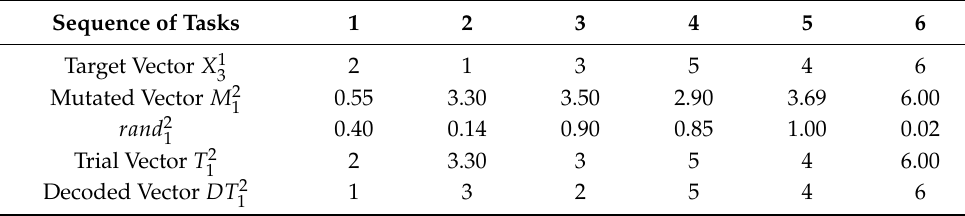
Table 3. An illustrative example of the target vector, the trial vector, and the decoded vector. Sequence of Tasks